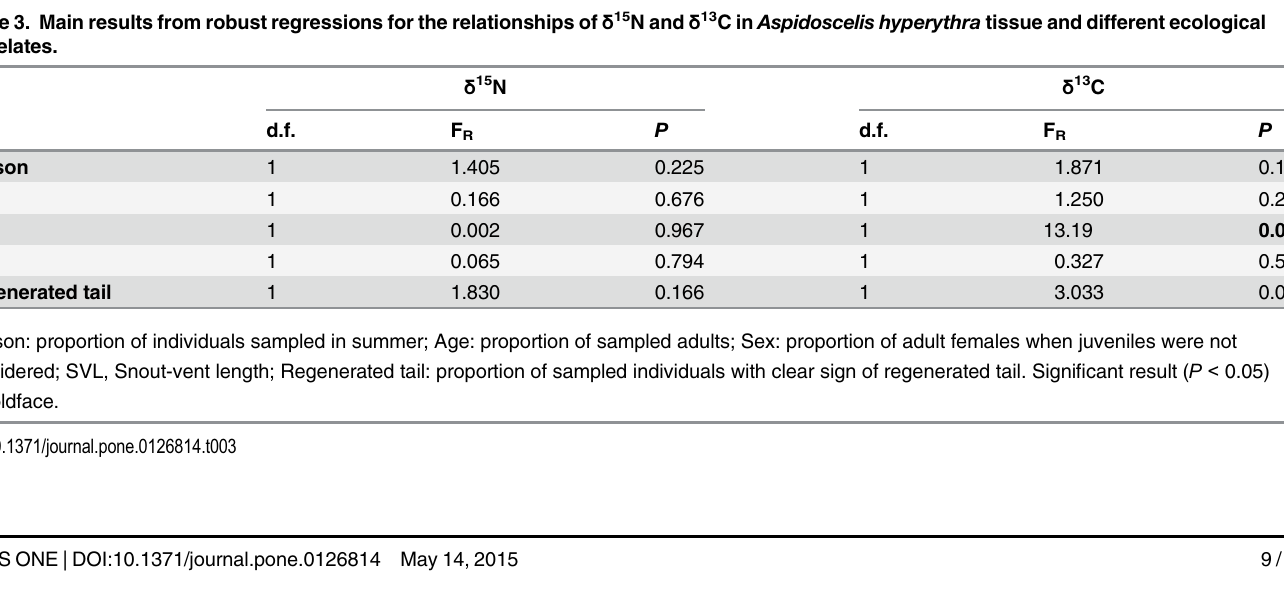
Table 3. Main results from robust regressions for the relationships of δ 15 N and δ 13 C in Aspidoscelis hyperythra tissue and different ecological correlates.